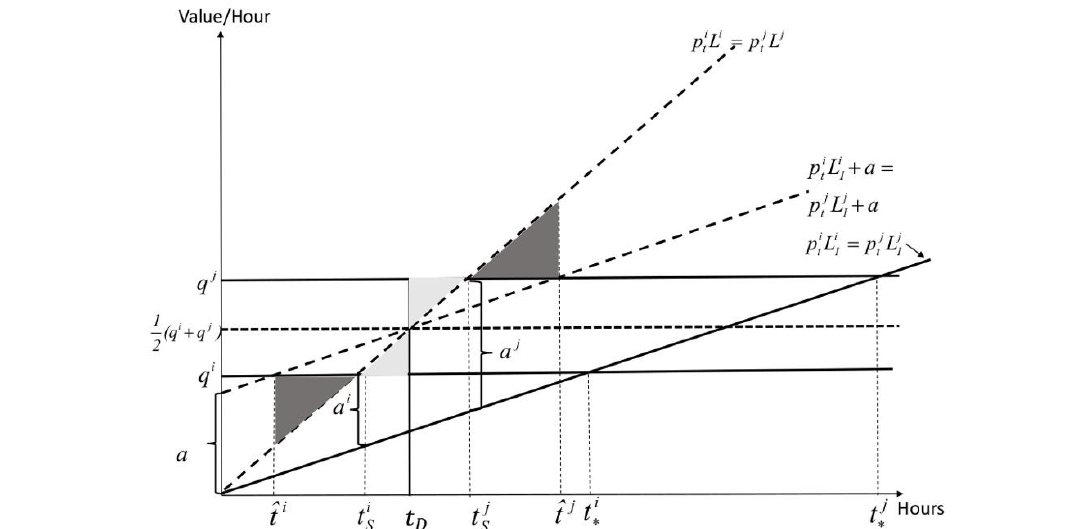
Figure 1. Optimal driving times for companies i and j when we assume that the two operators differ only in marginal net revenue, where 𝑞 𝑖 < 𝑞 𝑗 . The bold upward sloping line is the internal marginal cost (identical for these two companies), and the steepest dotted curve represents the expected marginal social cost. The profit maximum solutions, 𝑡 ∗𝑖 and 𝑡 ∗𝑗 , and the welfare optimal values, 𝑡 𝑆𝑖 and 𝑡 𝑆𝑗 , are marked on the horizontal axis. The uniform time restriction solution is 𝑡 𝐷 , and the total social expected loss stemming from these two firms due to the uniform time restriction is summarized by the two grey triangles. When a uniform tax, a, is implemented, the other increasing dotted curve represents the expected internal marginal costs including taxes, and 𝑡̂ 𝑖 and 𝑡̂ 𝑗 are the companies chosen driving times, and the unique (optimal) taxes for company i and company j are marked, 𝑎 𝑖 < 𝑎 𝑗 . The expected social loss stemming from these two companies due to uniform taxation is summarized by the two dark